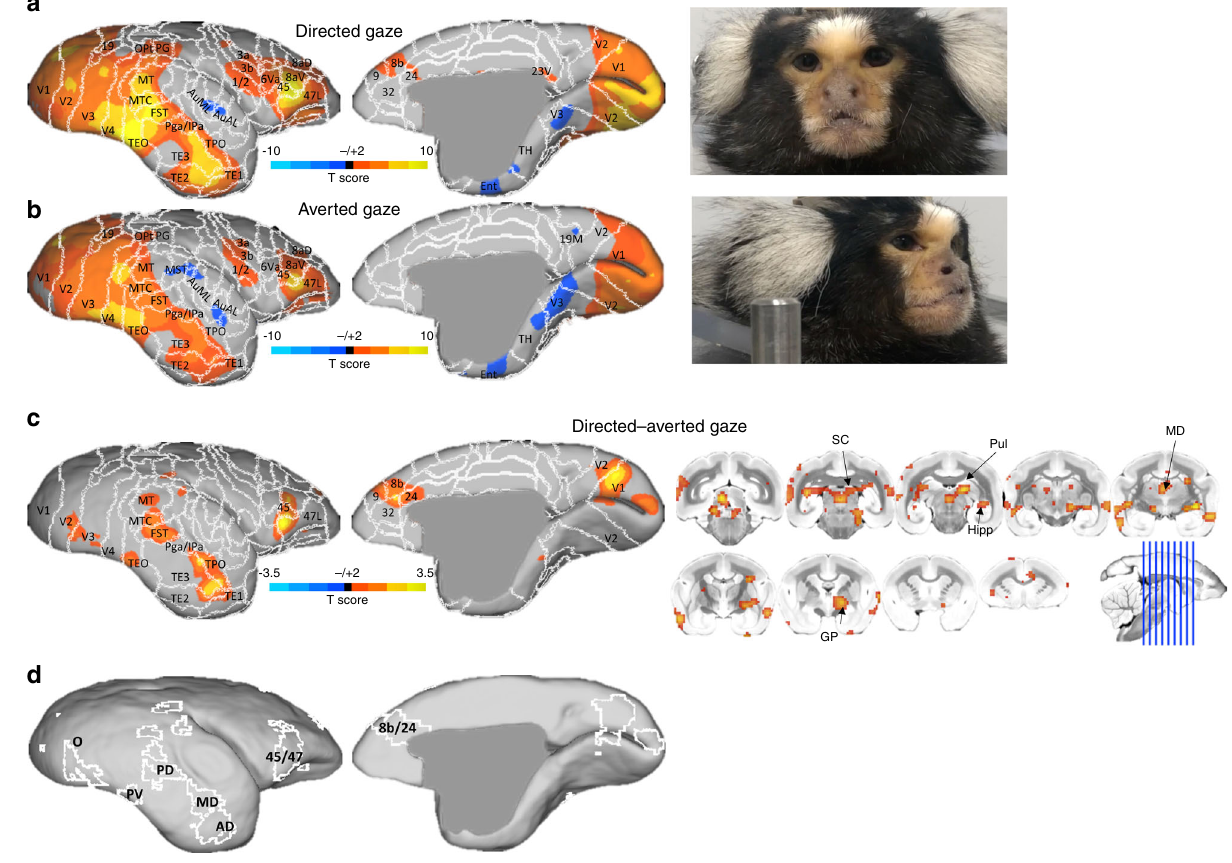
Fig. 2 Social face processing topologies. Group functional topology comparisons between directed and averted-gaze video conditions displayed on a marmoset cortical surface. a shows group topologies for directed gaze videos and b shows topologies for averted-gaze videos, with stills of representative stimuli to the right of each surface. c shows the contrast between the directed and averted-gaze conditions, with volumetric display (to show subcortical activation) to the right of the medial and lateral surfaces. d shows the outline of the pattern from c with the addition of labels for the face-selective